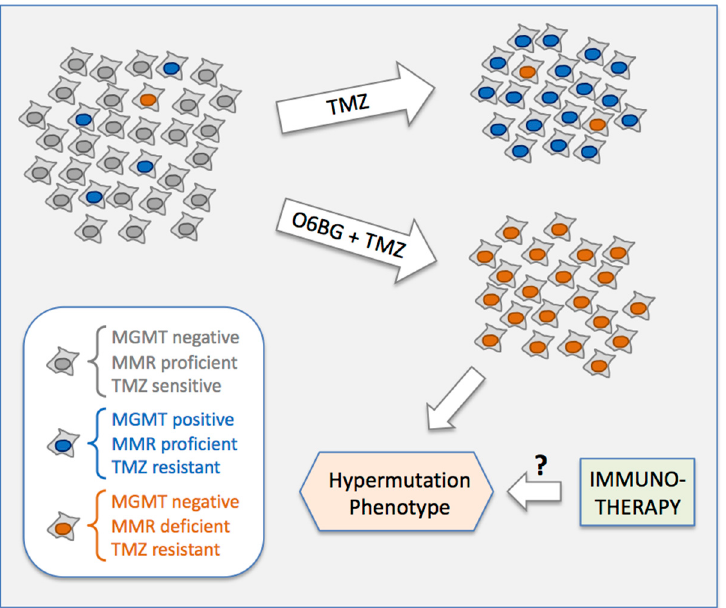
Figure 11. Model of selection of drug-resistant melanoma cell populations during treatment with TMZ, with or without added O6BG. Please note that rare MGMT-positive cells (blue) and even rarer MMR-deficient cells (orange) already are present in the parental cell population before the onset of drug treatment. Based on our results, there can also be mixed MGMT-positive/MMR-deficient cells (not displayed here); in such cells, MGMT would ensure survival in case of TMZ treatment, and MMR-deficiency would ensure survival in case of TMZ + O6BG combination treatment. See further details in Discussion and Conclusions sections.